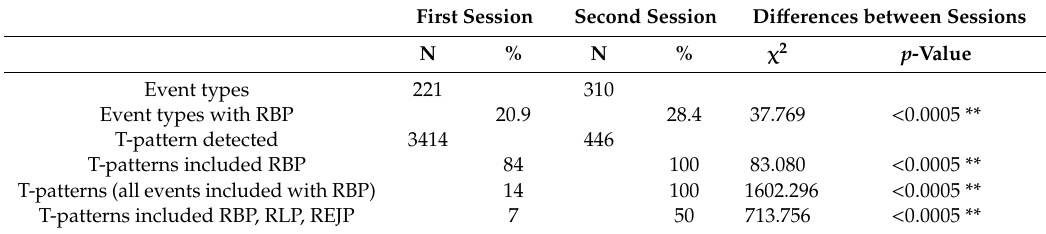
Table 4. T-patterns detected that included recommended positions and di ff erences between sessions.